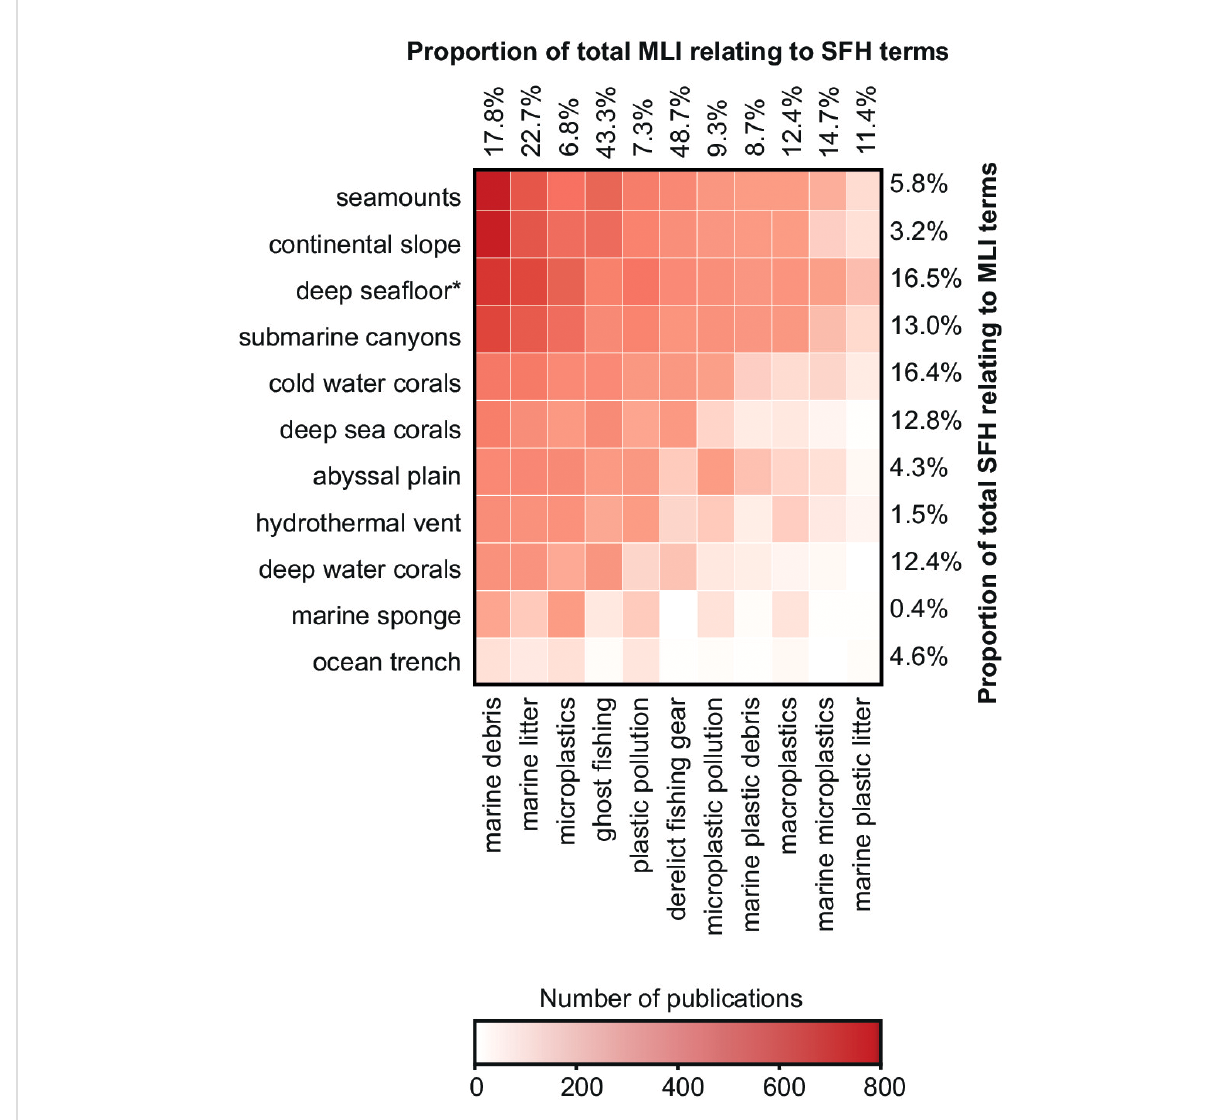
FIGURE 4 Heatmap for the cumulative number of publications for lexical unit combinations between lexical groupings, for the period 2001-2020 in Google Scholar. Proportion percentages were calculated as: MLI and SFH lexical unit combinations results 2001-2020 divided by single MLI